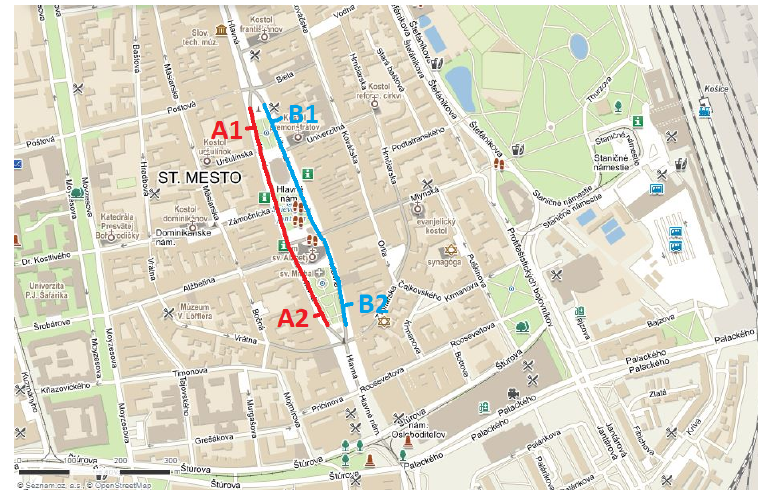
Figure 1. Two clusters (red and blue) with non-circular